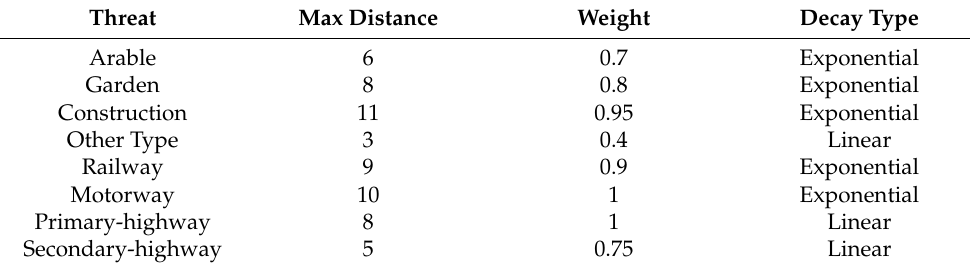
Table 3. Threat factor parameter settings.